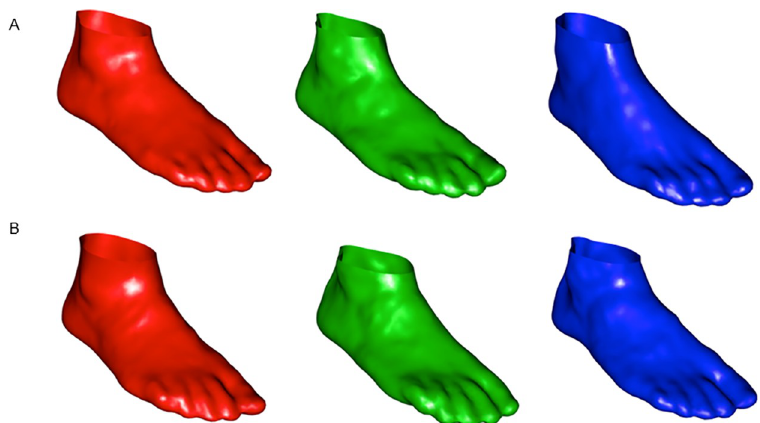
Fig 9. Three archetypoids obtained with 3D landmarks. (A) Archetypoids for women. (B) Archetypoids for men. The first archetypoids are shown in red, the second archetypoids in green, while the third archetypoids are shown in